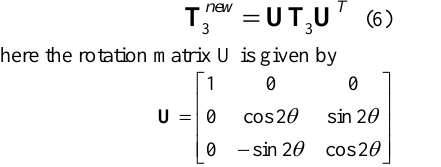
Figure 7. 3D DEM draped PolSAR image after correction To visualize the effect of data terrain correction, line profiles form the area B in figure 10 are plot in figure 8 for the diagonal elements of coherency matrix, before and after correction. The original radar brightness values are shown in red broken-line, the radiometric normalized values are shown in green line, the compensated with DEM values are shown in blue dotted-broken line and the after compensated with circular polarization values are shown in black dotted line. The power of |HH – VV| in figure 8(a) is consistently increased after the OA compensation, while the power of HV shown in figure 8(b) is correspondingly reduced and the |HH + VV| is roll invariant in figure 8(c).